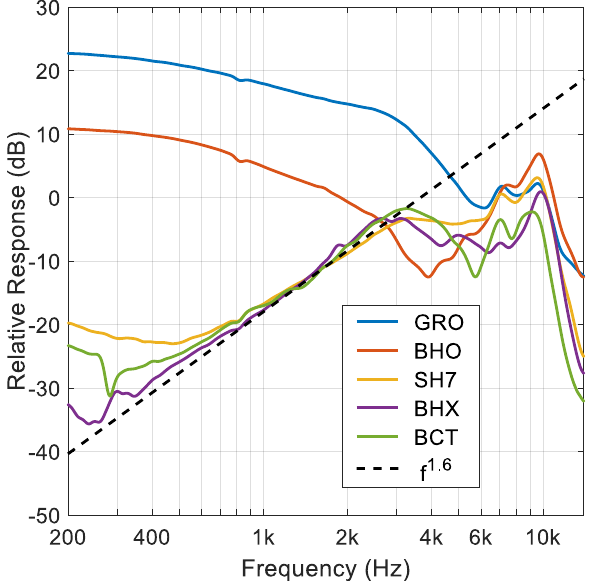
Figure 4. Frequency responses of the difference-frequency signal obtained with the tested microphones. The ultrasonic array was used as an emitter with a conventional DSBAM modulation.